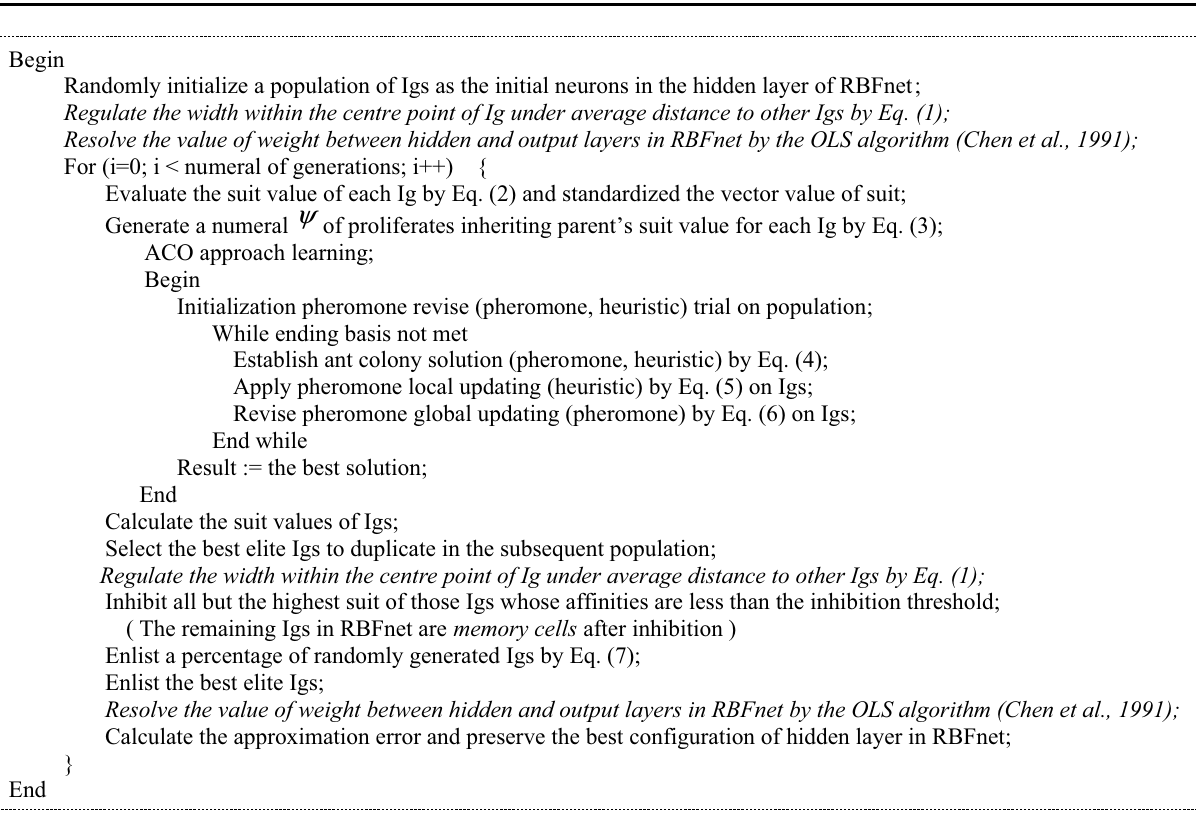
Fig. 2 The pseudo-code for the proposed HIAO